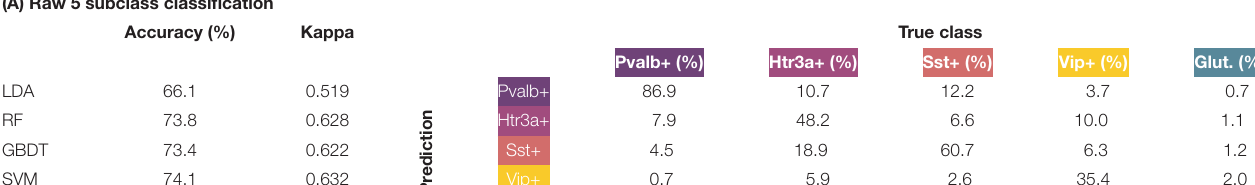
TABLE 3 | Cross-validated accuracy and kappa statistic of the different Machine Learning methods in the discrimination of the subclasses (left, best performer classifiers are marked in bold) and cross-validated confusion matrix of the best performer classifier -AvNNet in all cases- (right) in each of the defined stages. (A) Raw 5 subclass